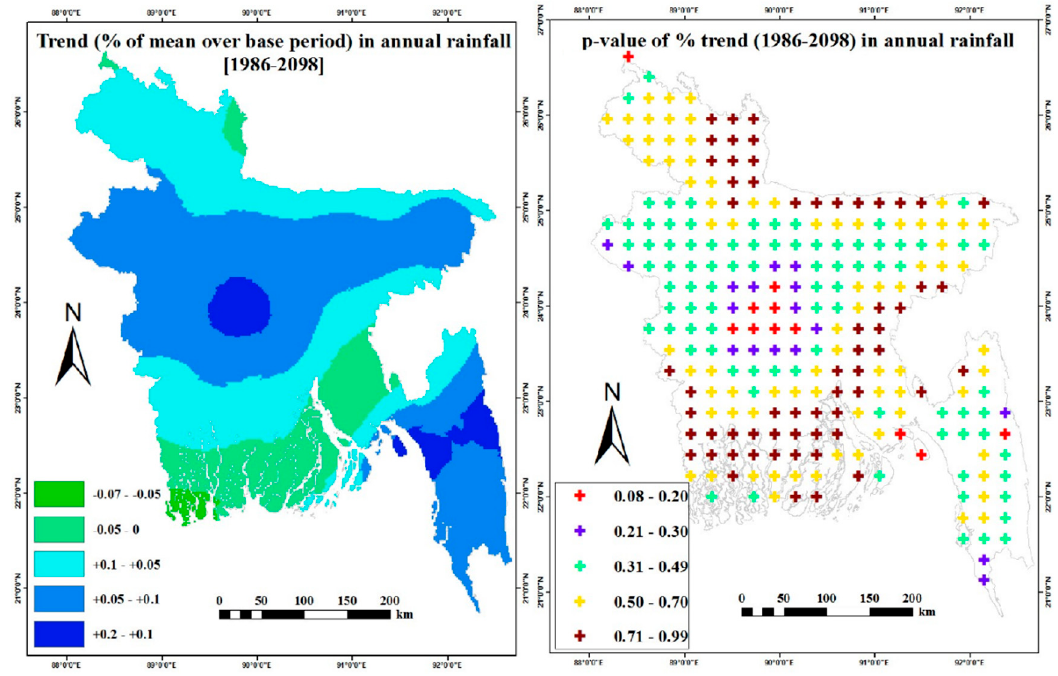
Figure 8. Spatial distribution of trends (% of mean of 1986–2005 in ( left ) in simulated annual rainfall